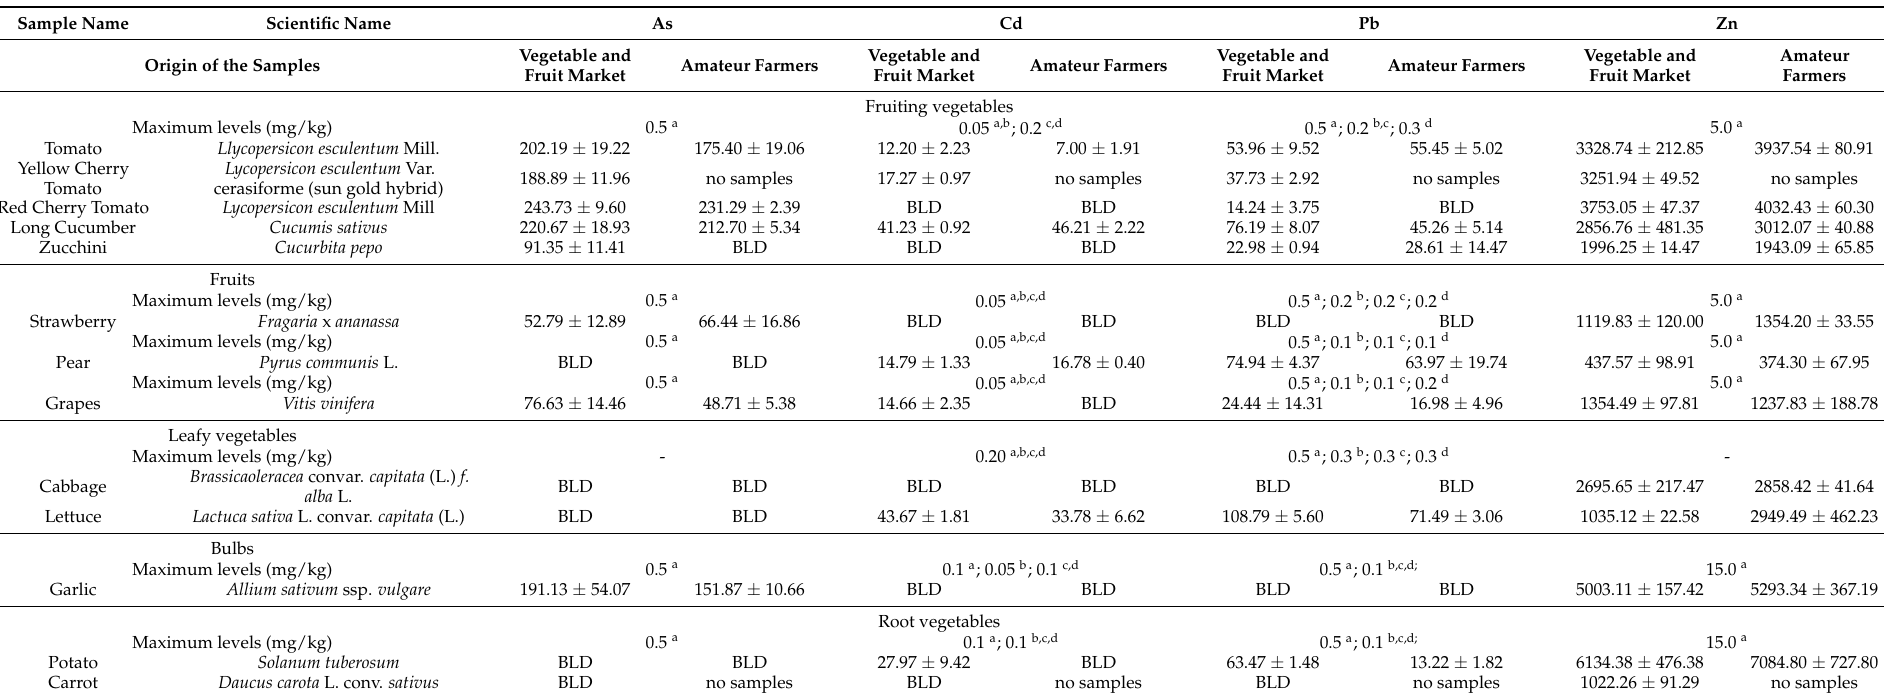
Table 2. Mean and standard deviation for heavy metal concentrations ( µ g/kg FW) in fruiting vegetables, fruits, leafy vegetables, bulbs, and root vegetables (n = 80) (samples washed with vinegar—5% acetic